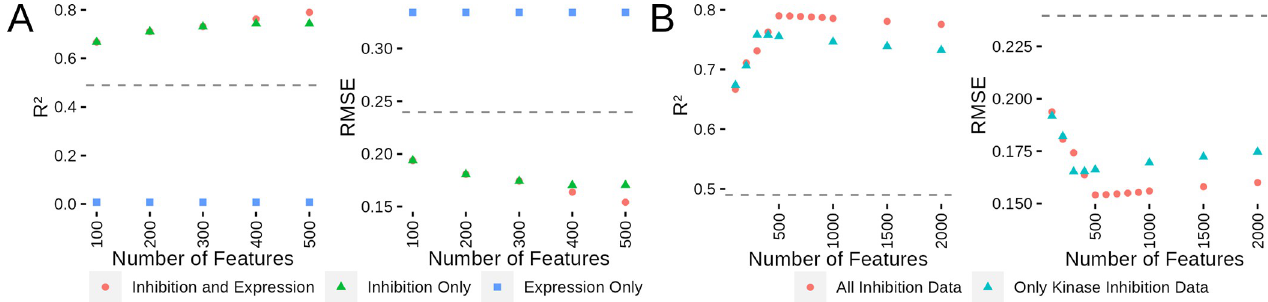
Fig 4. Model Performance is Best with Access to All Inhibition States and Gene Expression Values. (A) Comparison of R 2 and RMSE performance for models using only expression, only inhibition or inhibition and expression features. (B) Comparison of R 2 and RMSE performance for models using gene expression and all inhibition data or only the kinase subset. (C) Plots showing the order of feature selection for the single dose model. (D) Single dose model performance comparison across a range of feature count and with either kinase inhibition state and expression or expression alone.